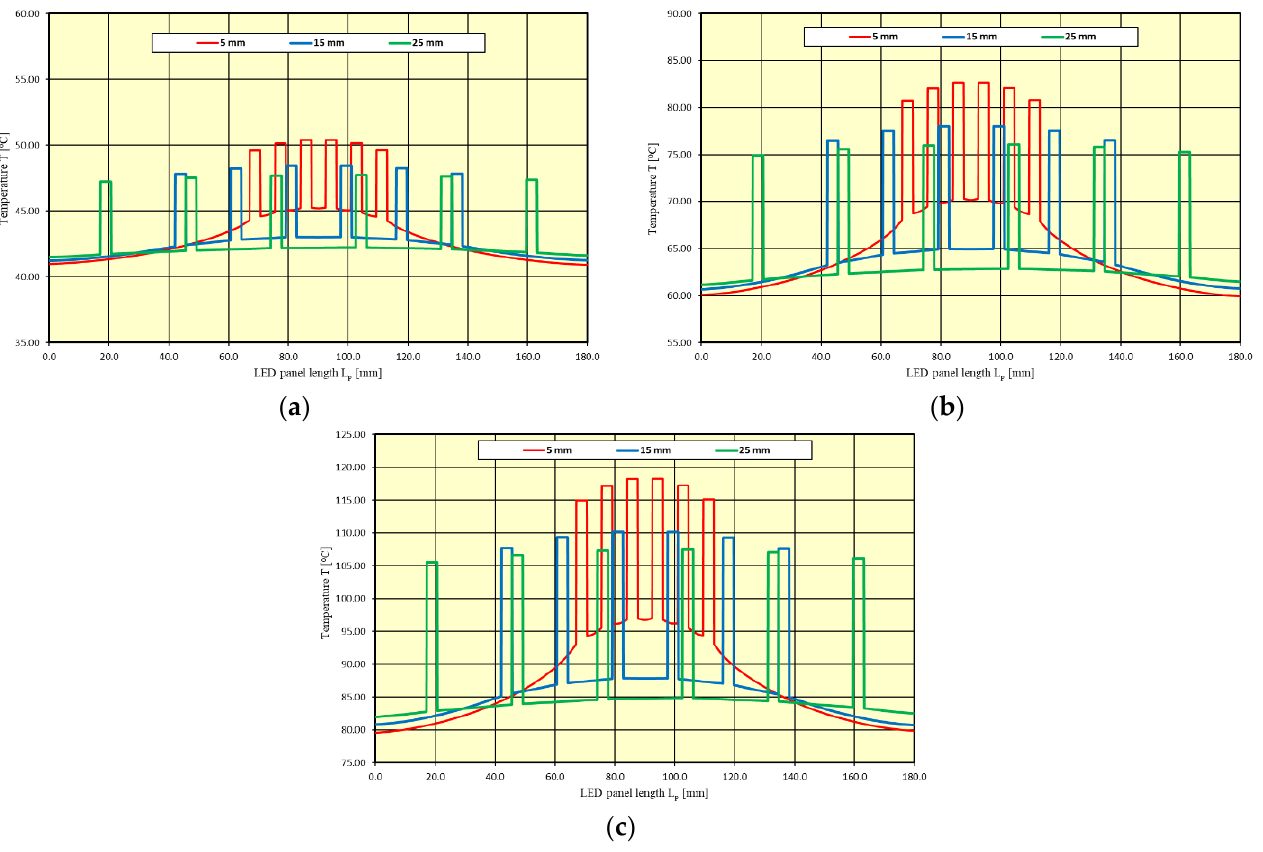
Figure 13. Temperature distribution of the LED panel at I F = 1050 mA: ( a ) d = 25 mm, ( b ) d = 5 mm. Temperature distribution of the LED panel along the axis with the maximum junction temperature T j of the installed LED sources for three values of forward current I F is shown in Figure 14.